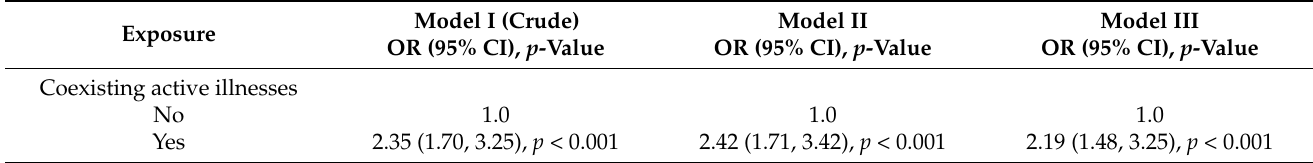
Table 3. Risk association of coexisting active illnesses in vaccinees and AKI death in different models.